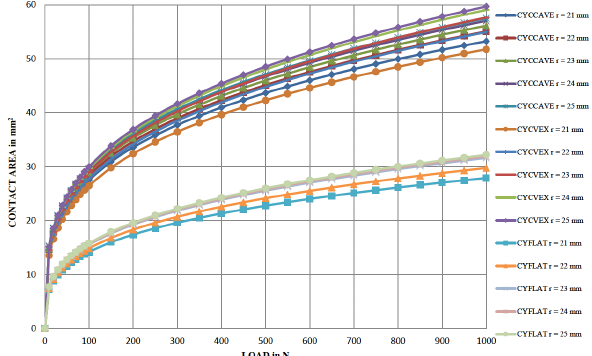
Figure 6: Comparison of area of contact versus applied normal force for cylindrical fingertips